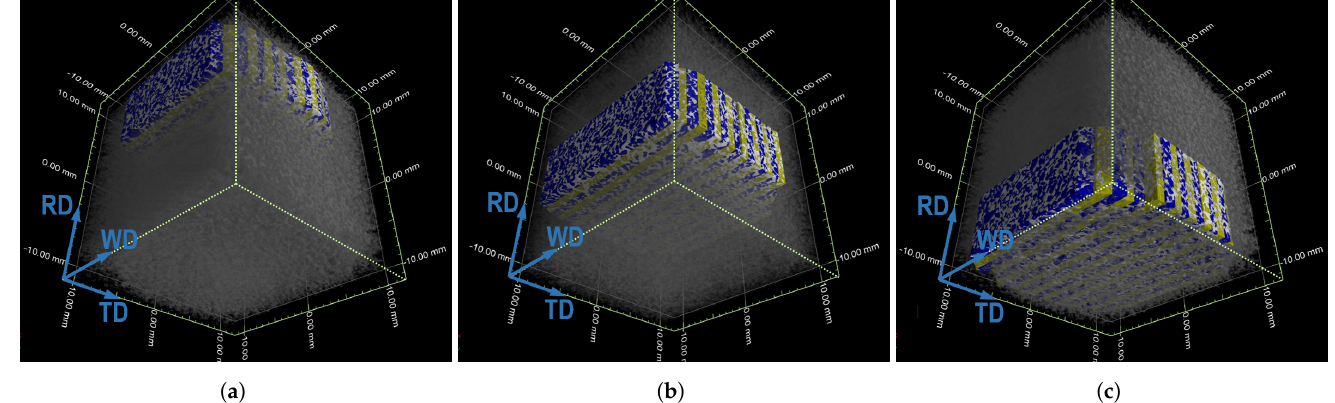
Figure 3. ROI stacks (Pore volume of different ROIs alternately highlighted in color) in sample with h 0 = 20mm (RD: rolling direction, TD: thickness direction i.e., roll gap direction, WD: width direction i.e., roll width direction): ( a ) First stack. ( b ) Second stack. ( c ) Third